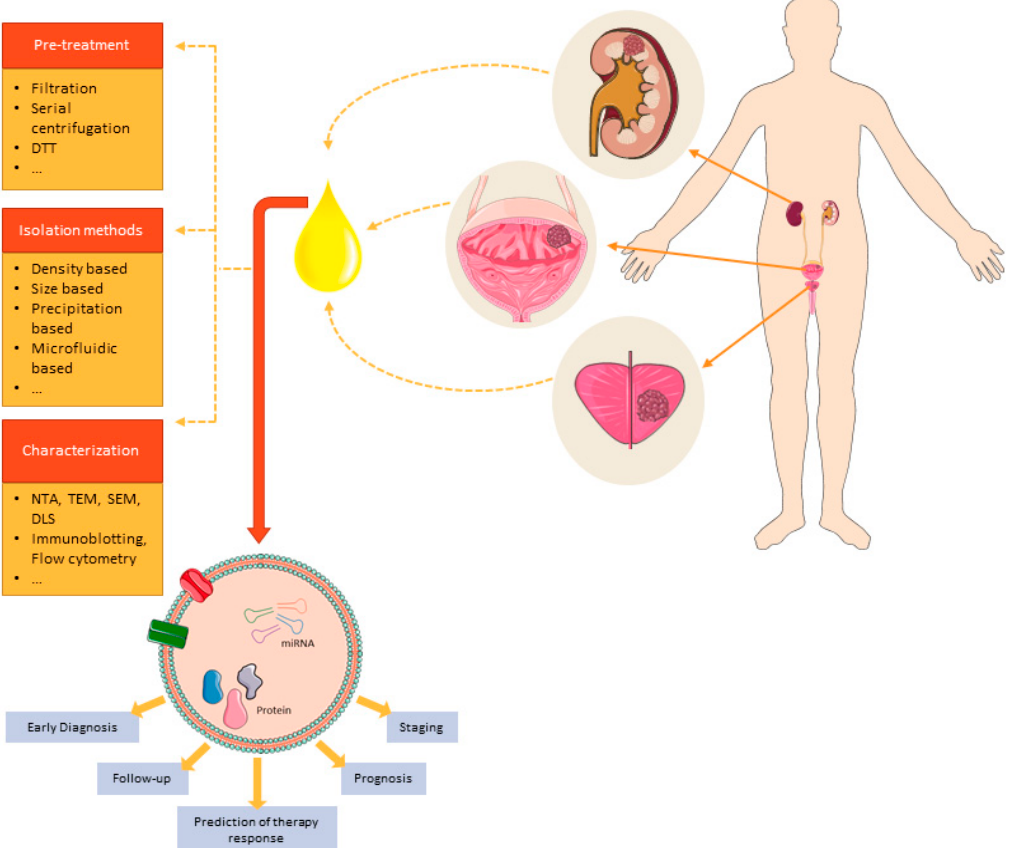
Figure 1. Overview of processing steps for uEVs-derived miRNA and protein biomarkers for urologic cancers.